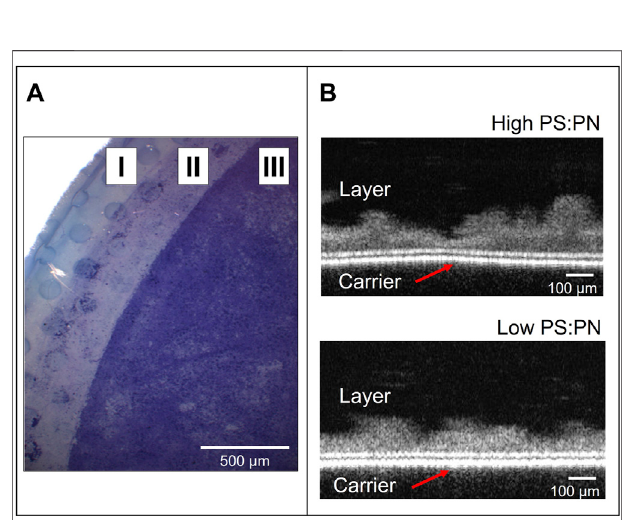
Table 1 , the PS:PN ratio of the anaerobic samples was similar. Lyophilized samples were used to prepare solutions in Milli-Q water at a concentration of 1 g sEPS L − 1 , which corresponding COD concentrations were 740 mg COD L − 1 for anaerobic and of 1,137 mg COD L − 1 for aerobic sEPS. These solutions were diluted to 100 mg COD L − 1 in Milli-Q water to obtain approximately The sEPS solutions were fi ltered through the 0.2 μ m PC carrier to form the gel layers, which were then collected and evaluated via bright fi eld stereomicroscopy and OCT ( Figure 2 ). Both sEPS layers were positive to 0.1% crystal violet staining, which indicates the deposition of microbial biopolymers on the PC carrier ’ s surface ( Figure 2A ), forming a gel layer covering the carrier.